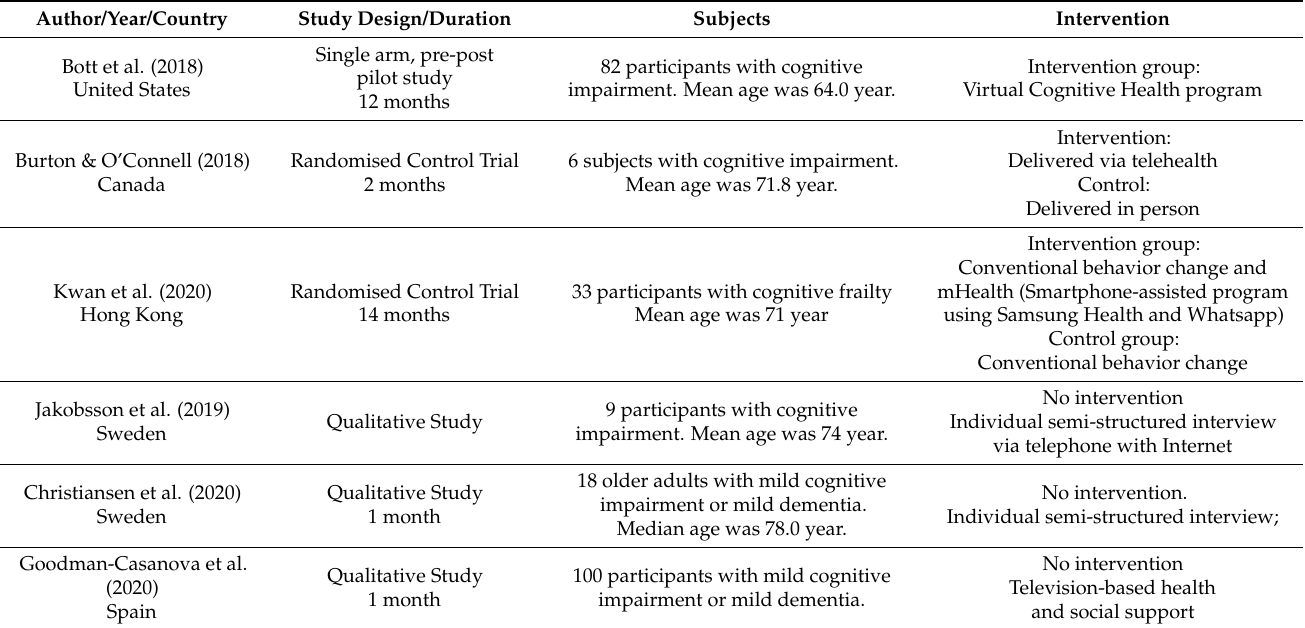
Table 2. Characteristics of the selected